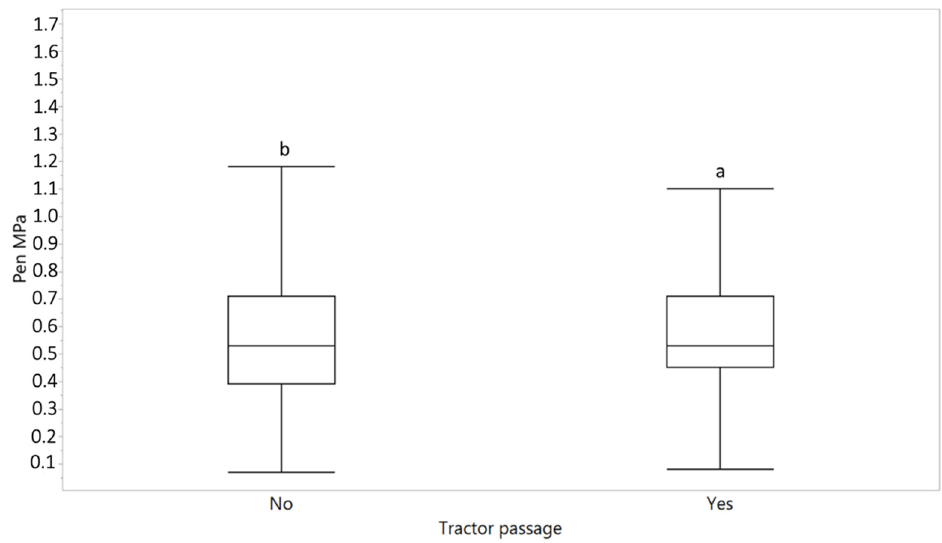
Figure 4. Penetration resistance in areas which the tractor has gone over and in areas not subject to the passage of tyres. The letters indicate a significant difference between these two areas at p ≤ 0.05.